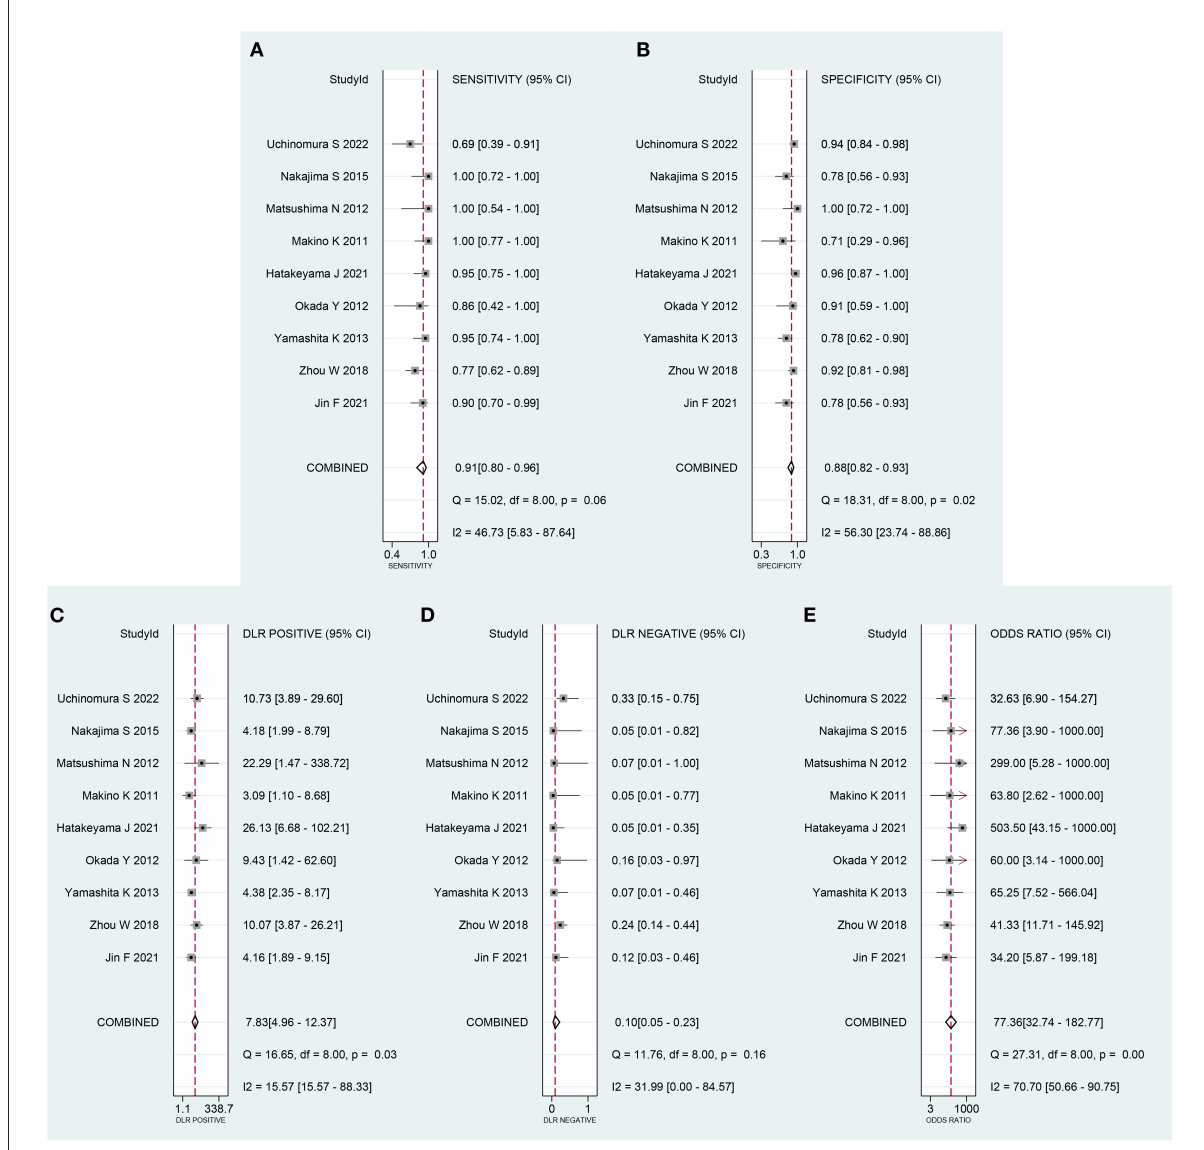
FIGURE2 Forest plot of combined (A) sensitivity (SEN) and (B) specificity (SPE), (C) positive likelihood ratio (PLR), (D) negative likelihood ratio (NLR) and (E) diagnostic odds ratio (DOR).